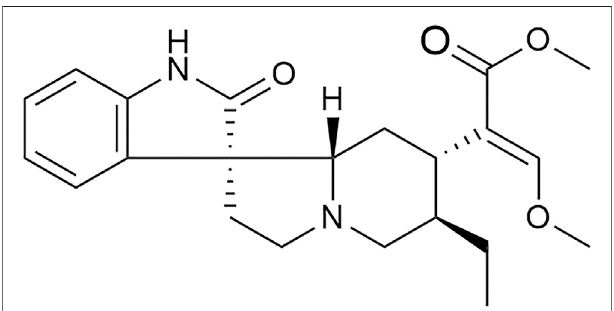
FIGURE 1 | Chemical structure of